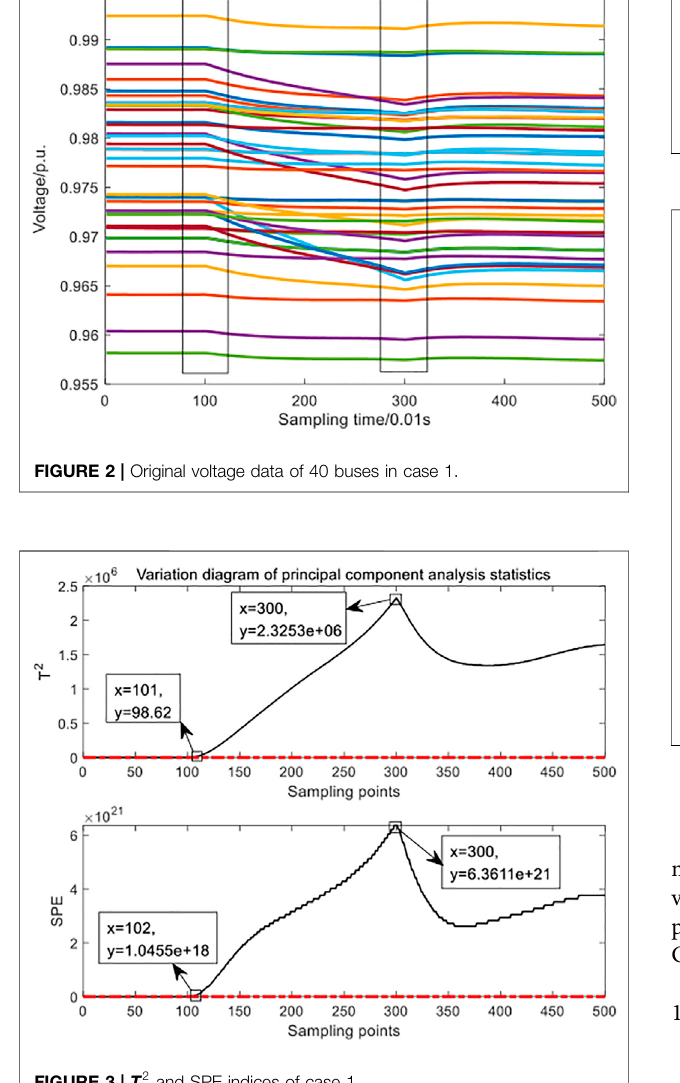
FIGURE 3 | T 2 and SPE indices of case 1.